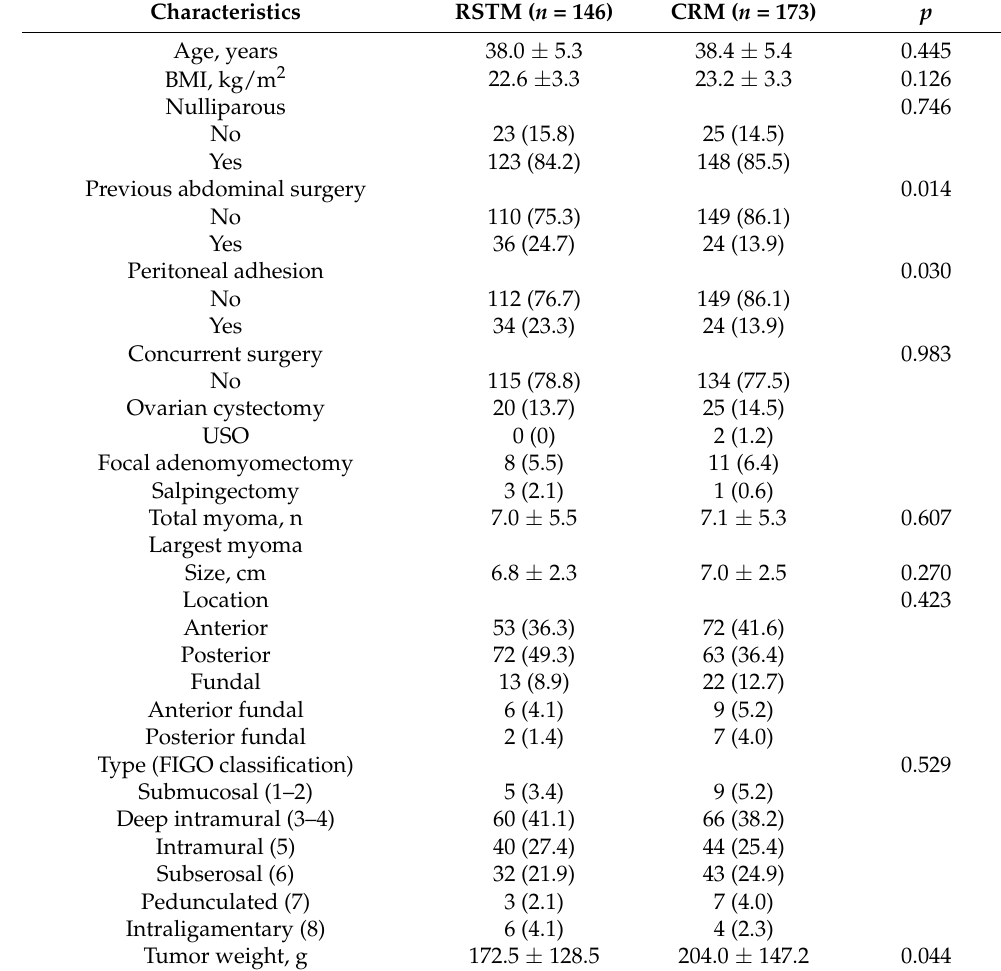
Table 1. Baseline characteristics of myomectomy patients.